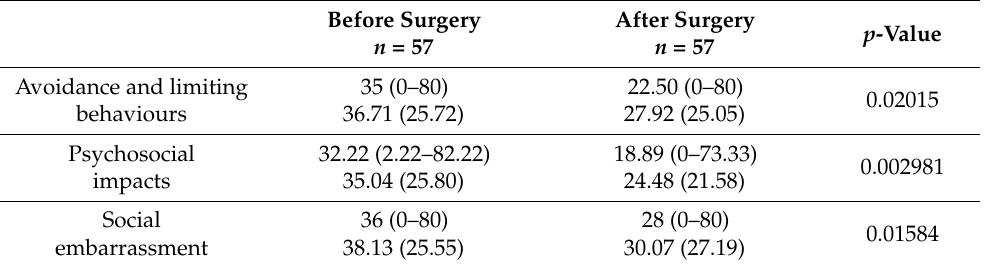
Table 3. Domain scores of the IQoL questionnaire from women before and after